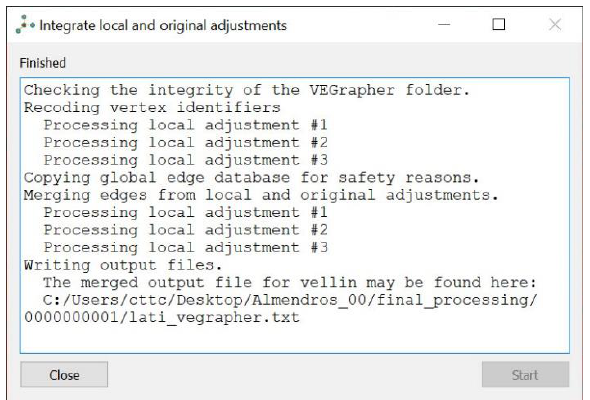
Figure 8: Harmonizing (merging) all the data